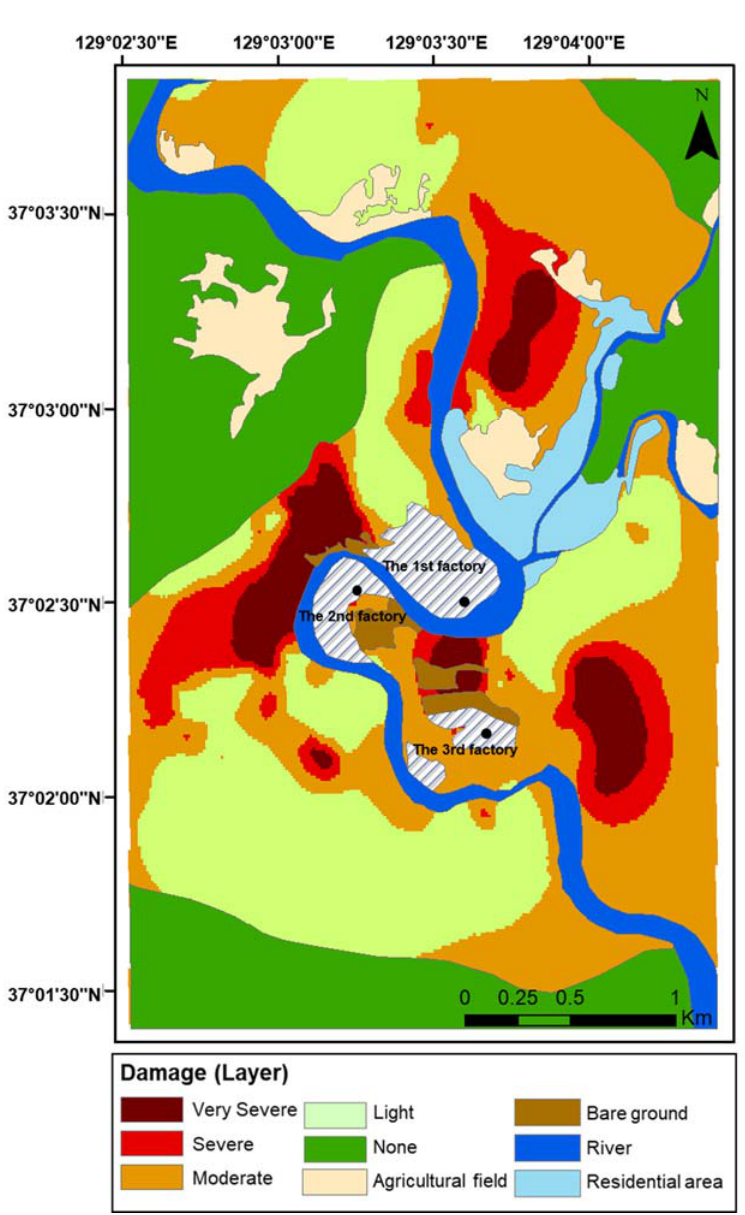
Figure 5. Spatial distribution of vegetation damage based on vegetation stratification in the study area.